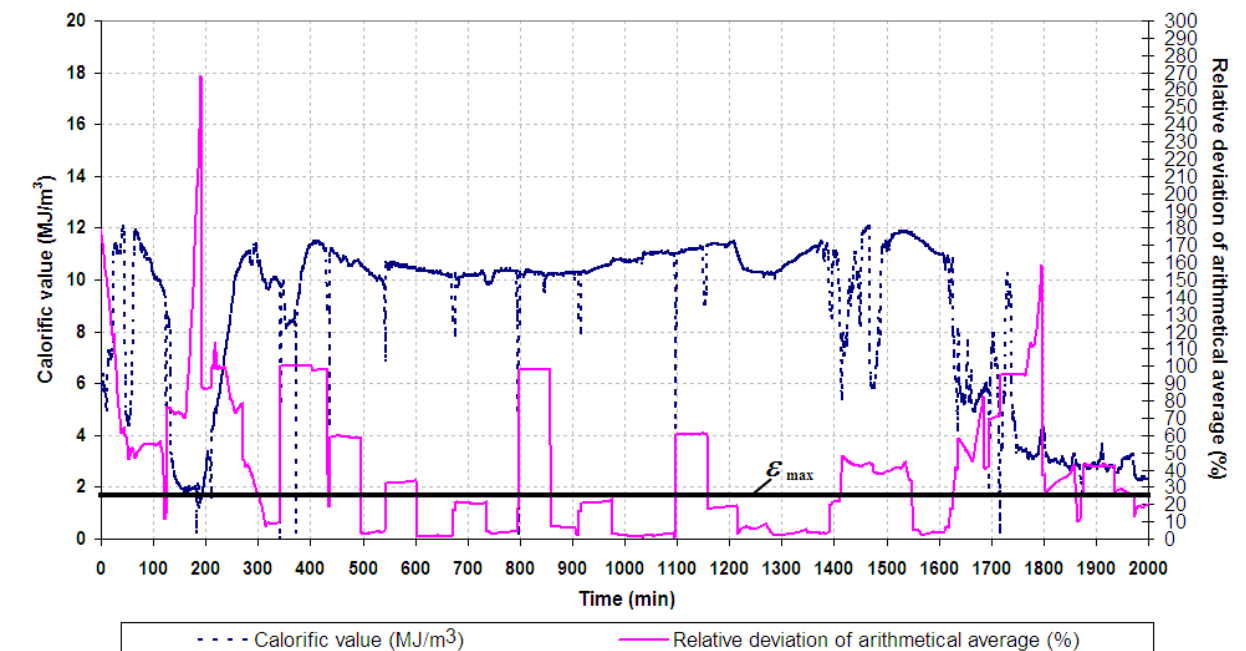
Figure 6. Principle of steady state searching.